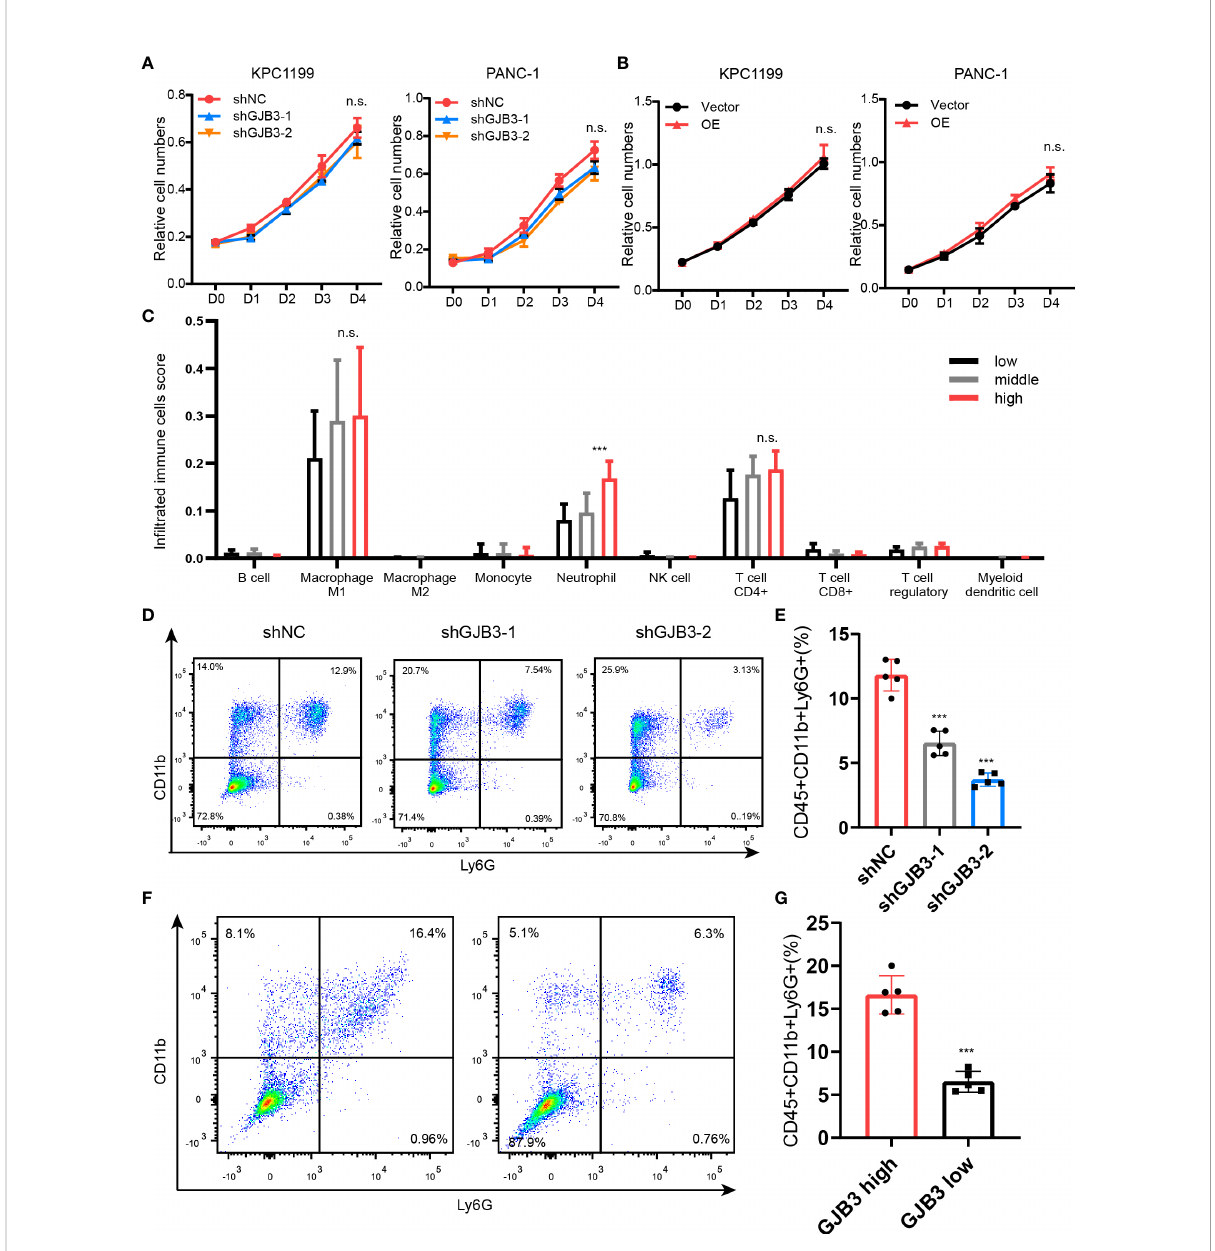
FIGURE 3 GJB3 knockdown reduced the neutrophil accumulation in liver metastasis. (A) . Cell proliferation assay of KPC1199 and PANC-1 cell with GJB3 knockdown or not. (B) . Cell proliferation assay of KPC1199 and PANC-1 cell with GJB3 ectopic expression or not. (C) . The estimation of immune cells in fi ltration in the PDAC liver metastasis. (D, E) . The fl ow cytometry of neutrophil in fi ltrated in the liver from shNC and shGJB3 group mice (n = 5). (F, G) . The fl ow cytometry of neutrophil in fi ltrated in the GJB3 high and low expression PDAC liver metastasis specimens (n = 5). Data presented as mean±standard deviation. ***P<0.001. ns, no signi fi